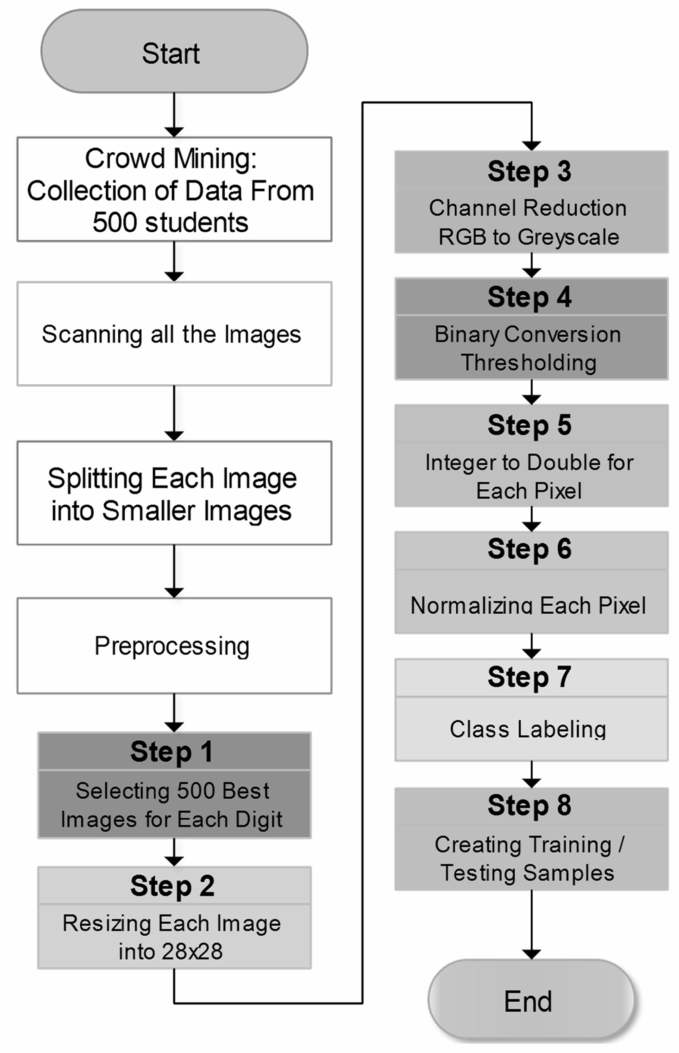
Figure 2. The Pashto Digit Dataset Collection and Preprocessing.